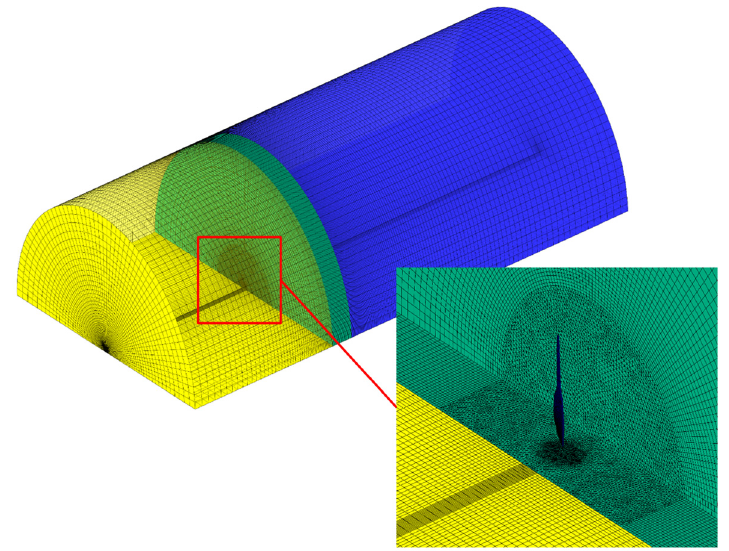
Figure 13. The generated mesh for the computational domain.